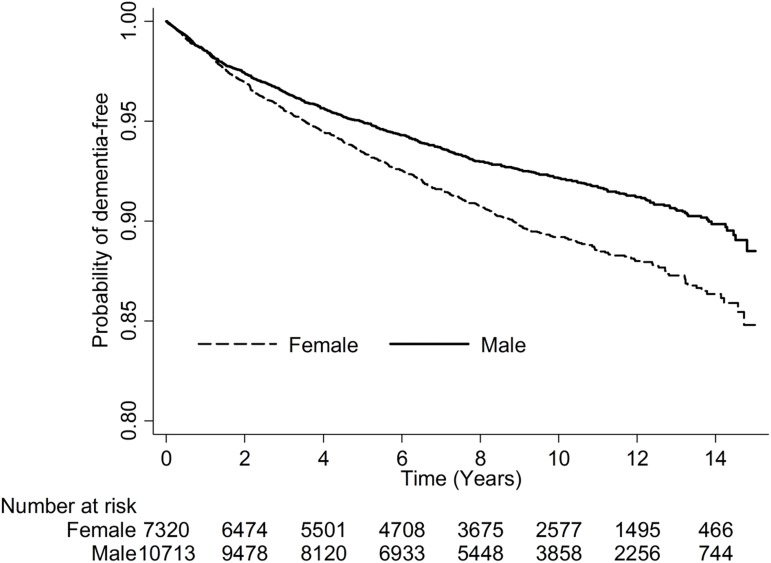
Kaplan-Meier curves show the probability of being dementia-free after hospital discharge for patients admitted to the intensive care unit and mechanically ventilated by age group (A), and by gender group(B) (p < 0.0001, log-rank test).